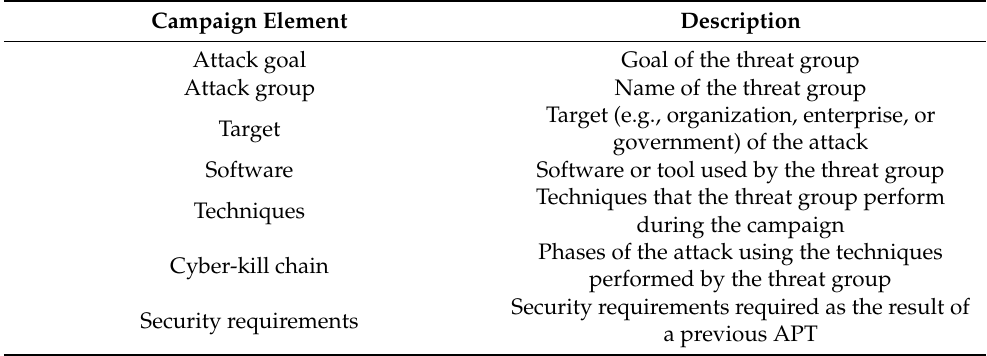
Table 4. Elements of an attack